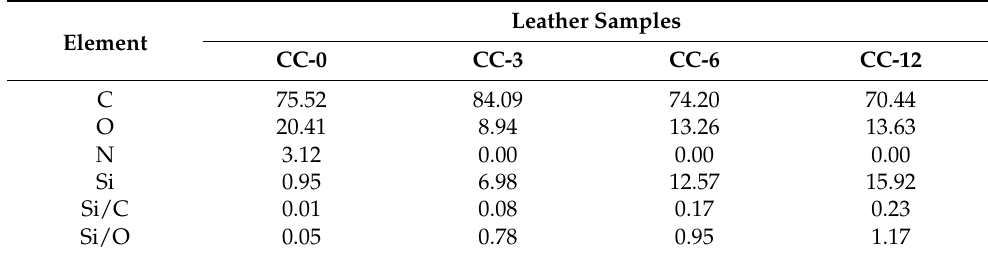
Table 2. Elemental composition of untreated and plasma-coated leather samples. Element